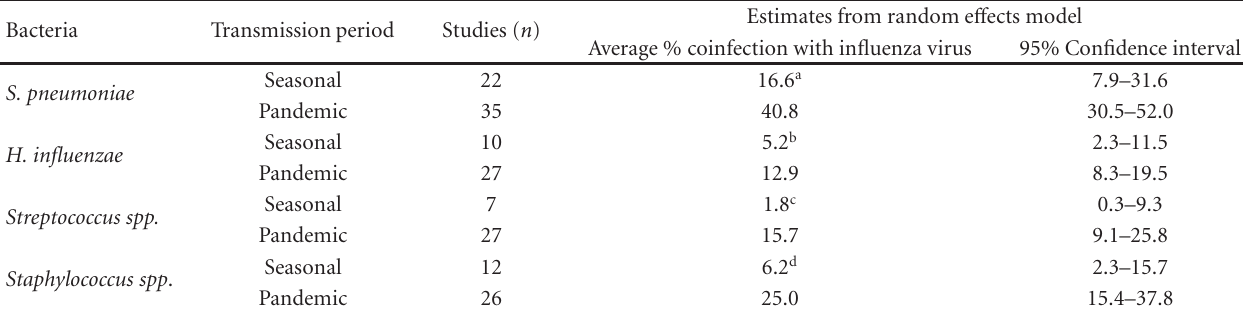
0 . 008). b Seasonal versus pandemic pooled average proportion of patients with H. influenzae coinfection ( P = . 02, Kruskal-Wallis test; Bonferonni correction, α = 0 . 008). c Seasonal versus pandemic pooled average proportion of patients with Streptococcus spp . coinfection ( P = . 009, Kruskal-Wallis test; Bonferonni correction, α = 0 . 008). d Seasonal versus pandemic pooled average proportion of patients with Staphylococcus spp . coinfection ( P = . 005, Kruskal-Wallis test; Bonferonni correction, α =